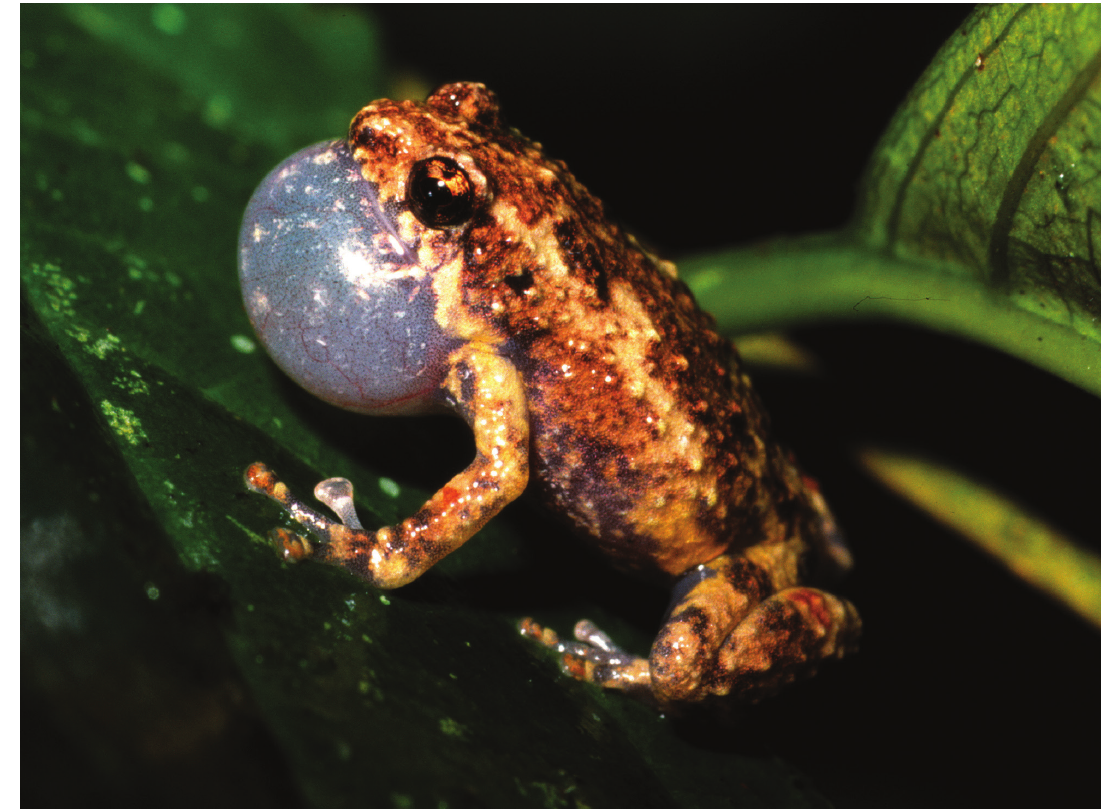
Figure 2. Paratype SAMA R69440 of Choerophryne crucifer sp. n. in life.